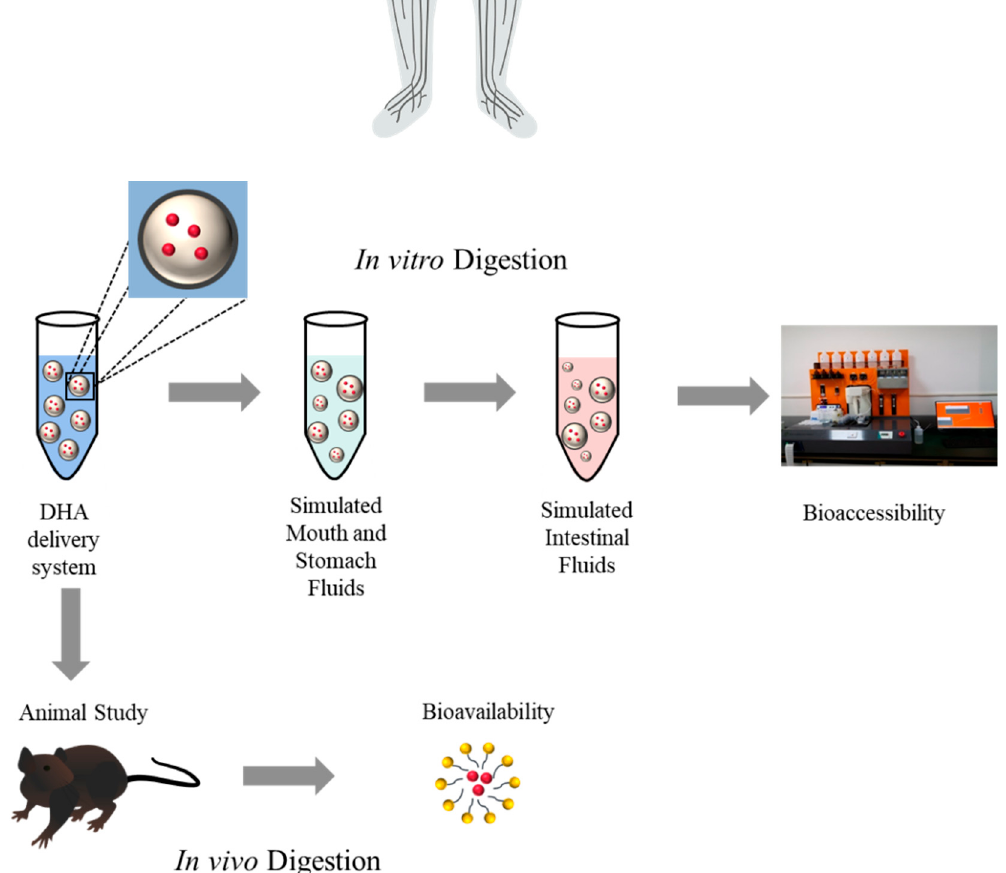
Figure 3. In vitro and in vivo digestion model of DHA delivery systems.